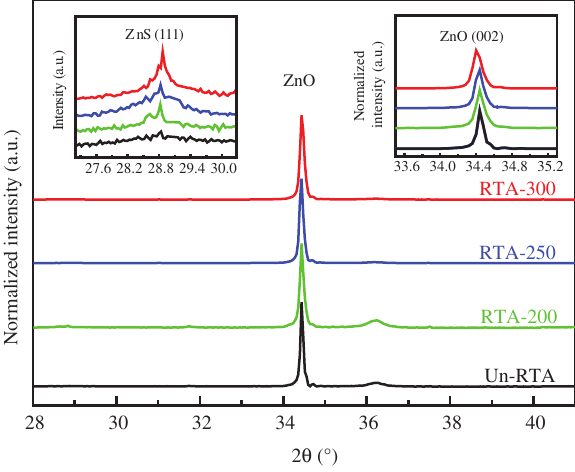
Figure 2: X-ray diffraction patterns of Un-RTA, RTA-200, RTA-250, and RTA-300,